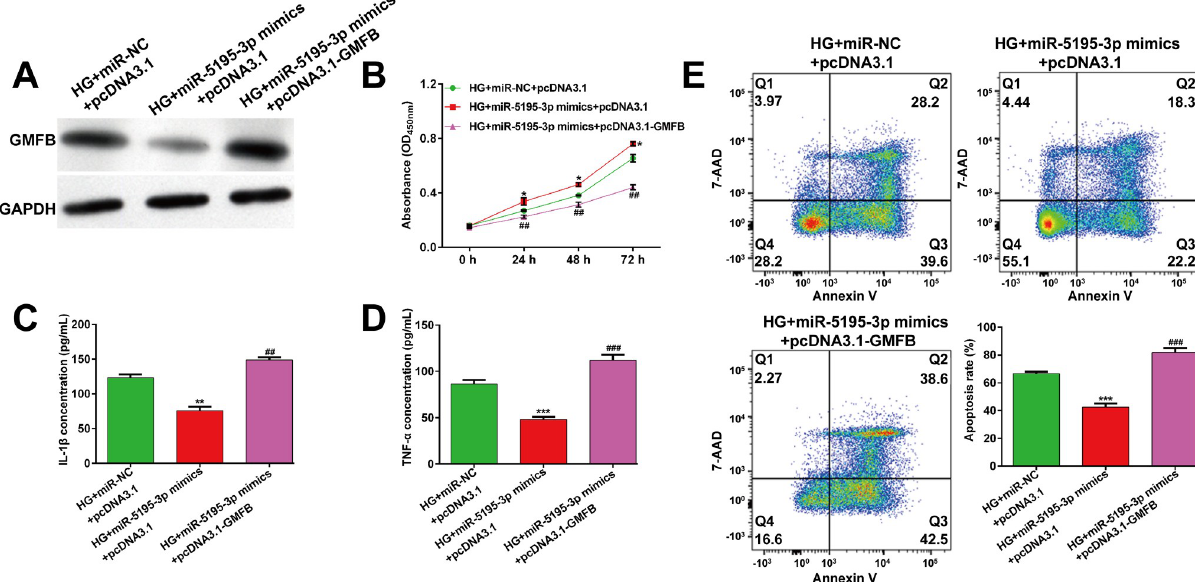
Fig 4. Overexpression of GMFB reversed the protective effects of miR-5195-3p overexpression against HG-induced ARPE-19 cell injury. ARPE-19 cells were co-transfected with miR-5195-3p mimics with either pcDNA3.1-GMFB or pcDNA3.1, followed by 24 h incubation with HG. (A) The protein expression of GMFB was detected by western blot analysis. (B) Cell viability was analyzed using CCK-8 assay. (C-D) ELISA assay was performed to analyze the release of IL-1 β and TNF- α in transfected ARPE-19 cells, followed by HG stimulation. (E) The percentages of apoptotic cells were compared in transfected ARPE-19 cells, followed by HG stimulation. Data were shown as mean ± SD. � p < 0.05, �� p < 0.01, ��� p < 0.001, compared with HG + miR-NC + pcDNA3.1; ## p < 0.01, ### p < 0.001, compared with HG + miR-5195-3p mimics + pcDNA3.1; NC, negative control; HG, high glucose.